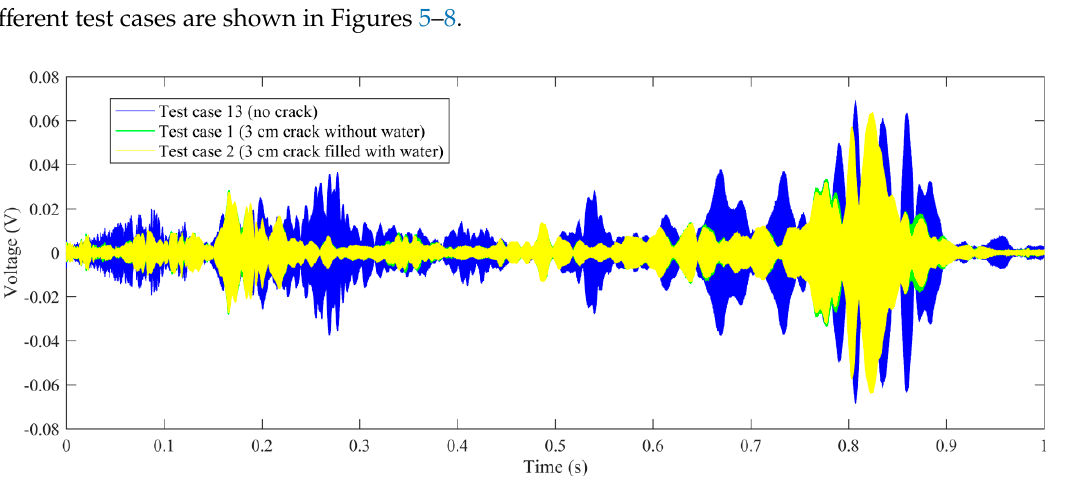
Figure 5. The comparison of voltage signals: test case 13 (no crack), test case 1 (3 cm crack without water), test case 2 (3 cm crack filled with water).